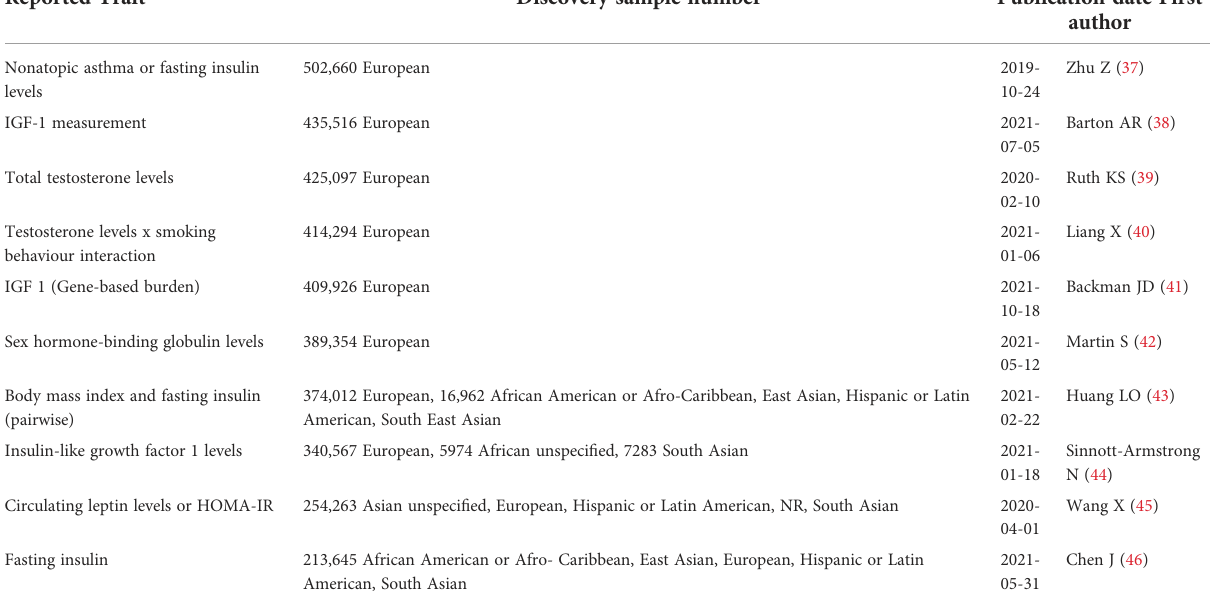
TABLE 1 Top 10 GWAS as determined by discovery sample size, obtained from GWAS catalog (7) under EFO term “ hormone measurment ” (EFO_0004730). Reported